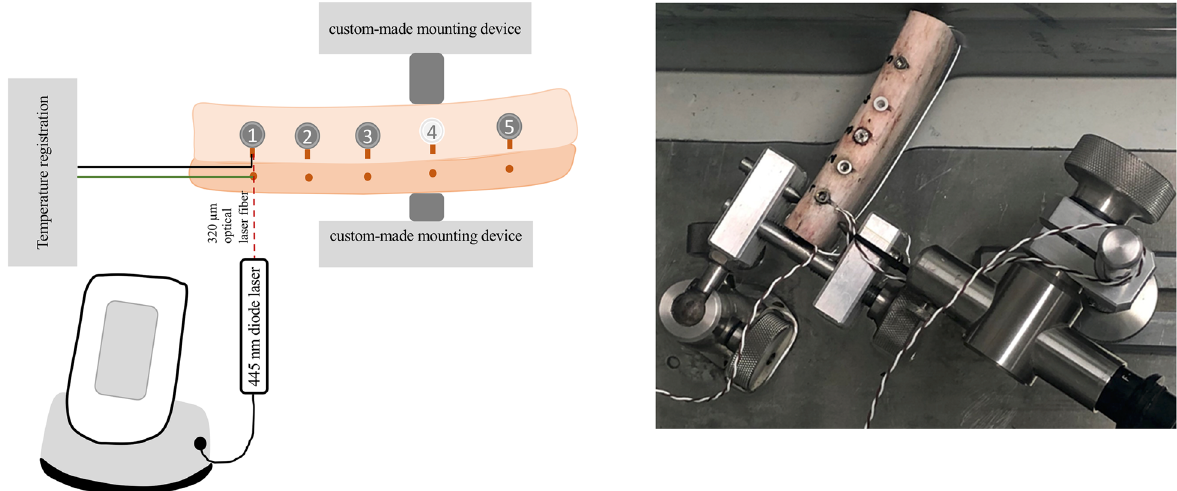
Figure 4. In vitro experimental setup. The implant-bearing bone is fixed in a water bath (37 °C). The 320 µm optical laser fiber of the SIROLaser Blue (Dentsply Sirona; Bensheim, Germany) aimed 90 degrees toward the dental implant surface in a horizontal direction. Two thermocouples were applied for temperature recordings on the side of laser irradiation: ( 1 ) at the implant–bone interface (black line) and ( 2 ) 3 mm above the most apical region of each implant (green